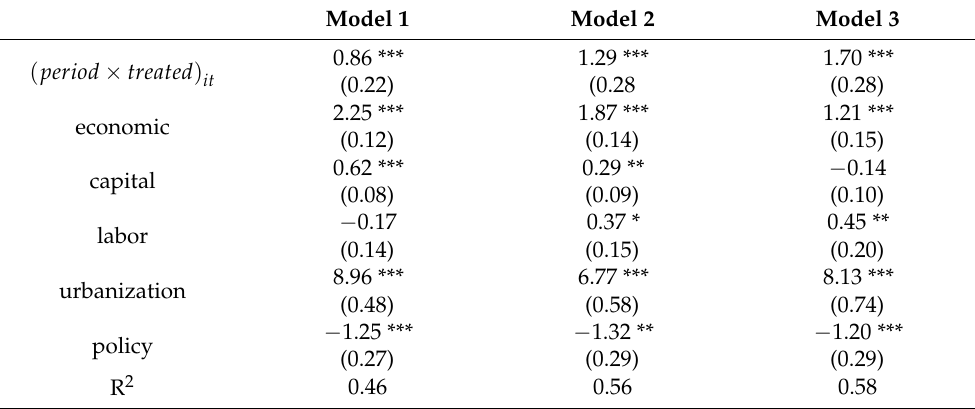
Table 2. Regression results of the HSR operation on